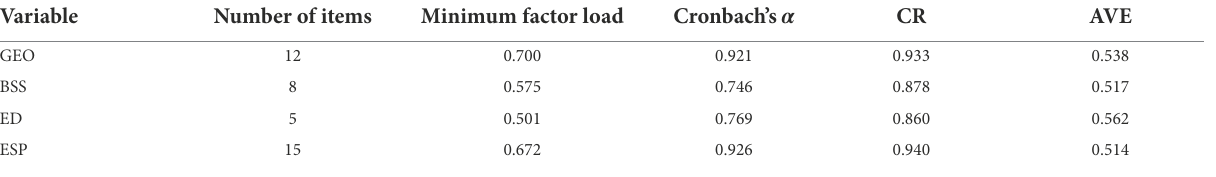
TABLE 2 Reliability and convergence validity tests.